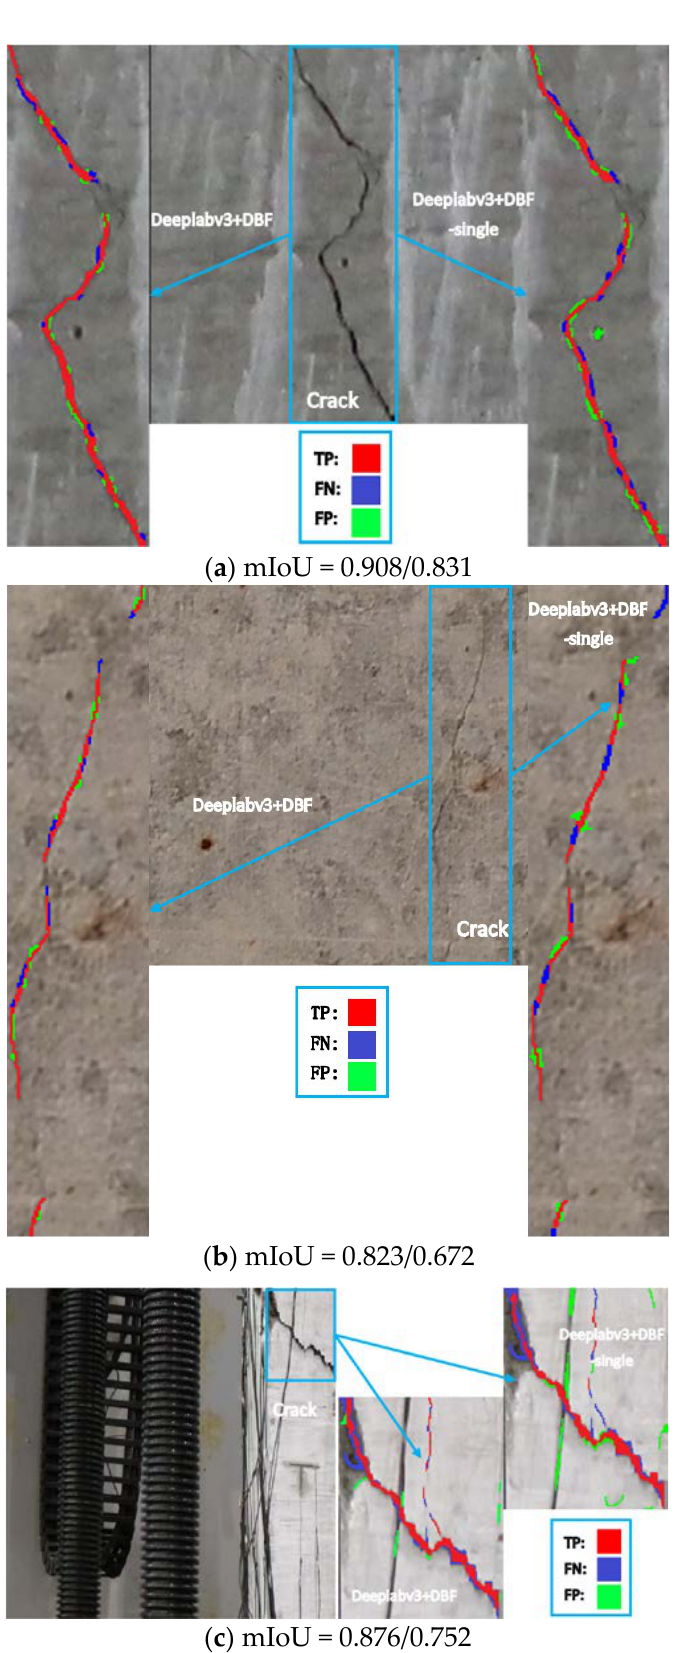
Figure 10. Typical segmentation results.